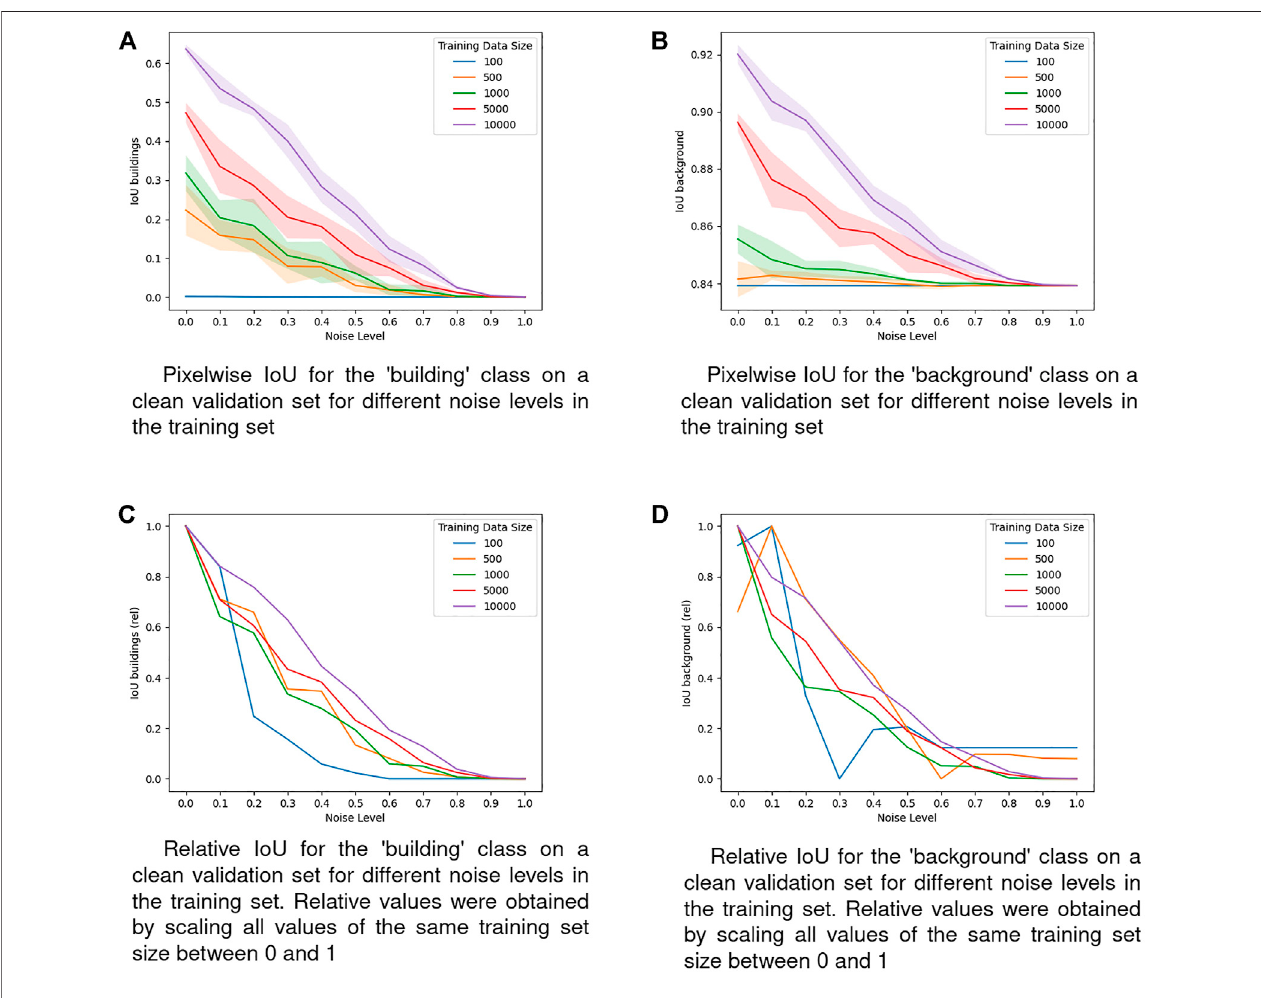
FIGURE4| IoUonthevalidation datasetforthetwoclasses. (A) PixelwiseloUforthe ‘ building ’ classonaclean validation setfordifferentnoiselevelsinthetraining set. (B) Pixelwise loU for the ‘ background ’ class on a clean validation set for different noise levels in the training set. (C) Relative loU for the ‘ building ’ class on a clean validationsetfordifferentnoiselevelsinthetrainingset.Relativesvalueswereobtainedbyscalingallvaluesofthesametrainingsetsizebetween0and1. (D) RelativeloU for the ‘ background ’ class on a clean validation set for different noise levels in the training set. Relatives values were obtained by scaling all values of the same training set size between 0 and